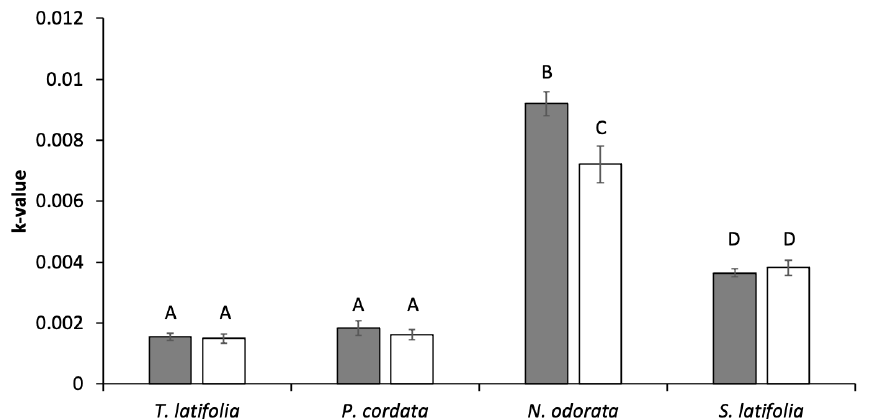
Figure 3. Decomposition rate of the four dominant macrophytes in caged (grey) and uncaged (white) plots. There was a significant interaction between species and treatment, and letters indicate statistical differences between average k-values, p <